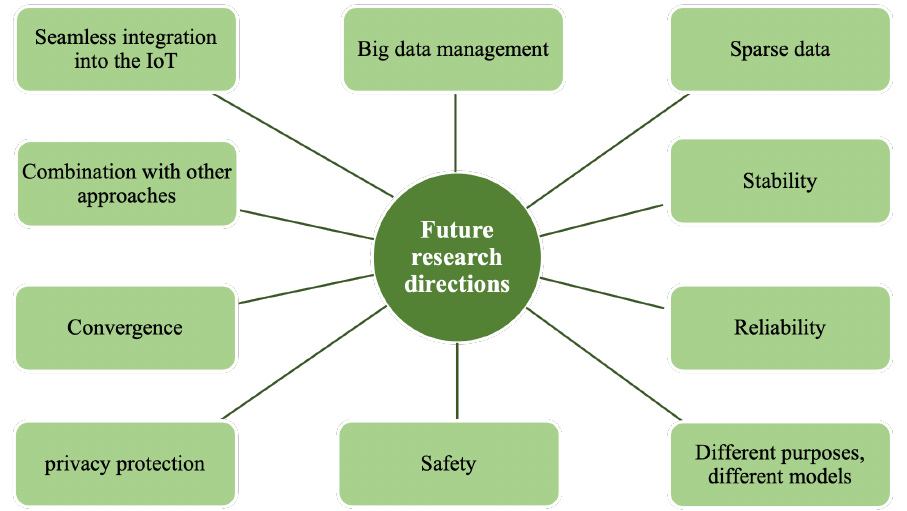
Figure 7. Several valuable future research directions of Iov with